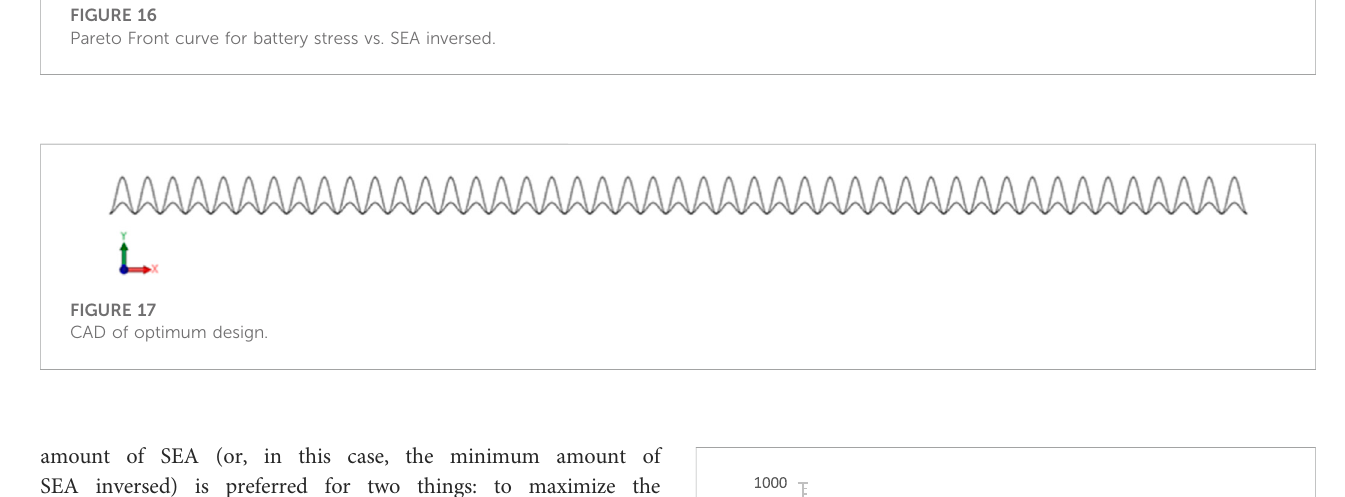
Pareto Front curve for battery stress vs. SEA inversed.